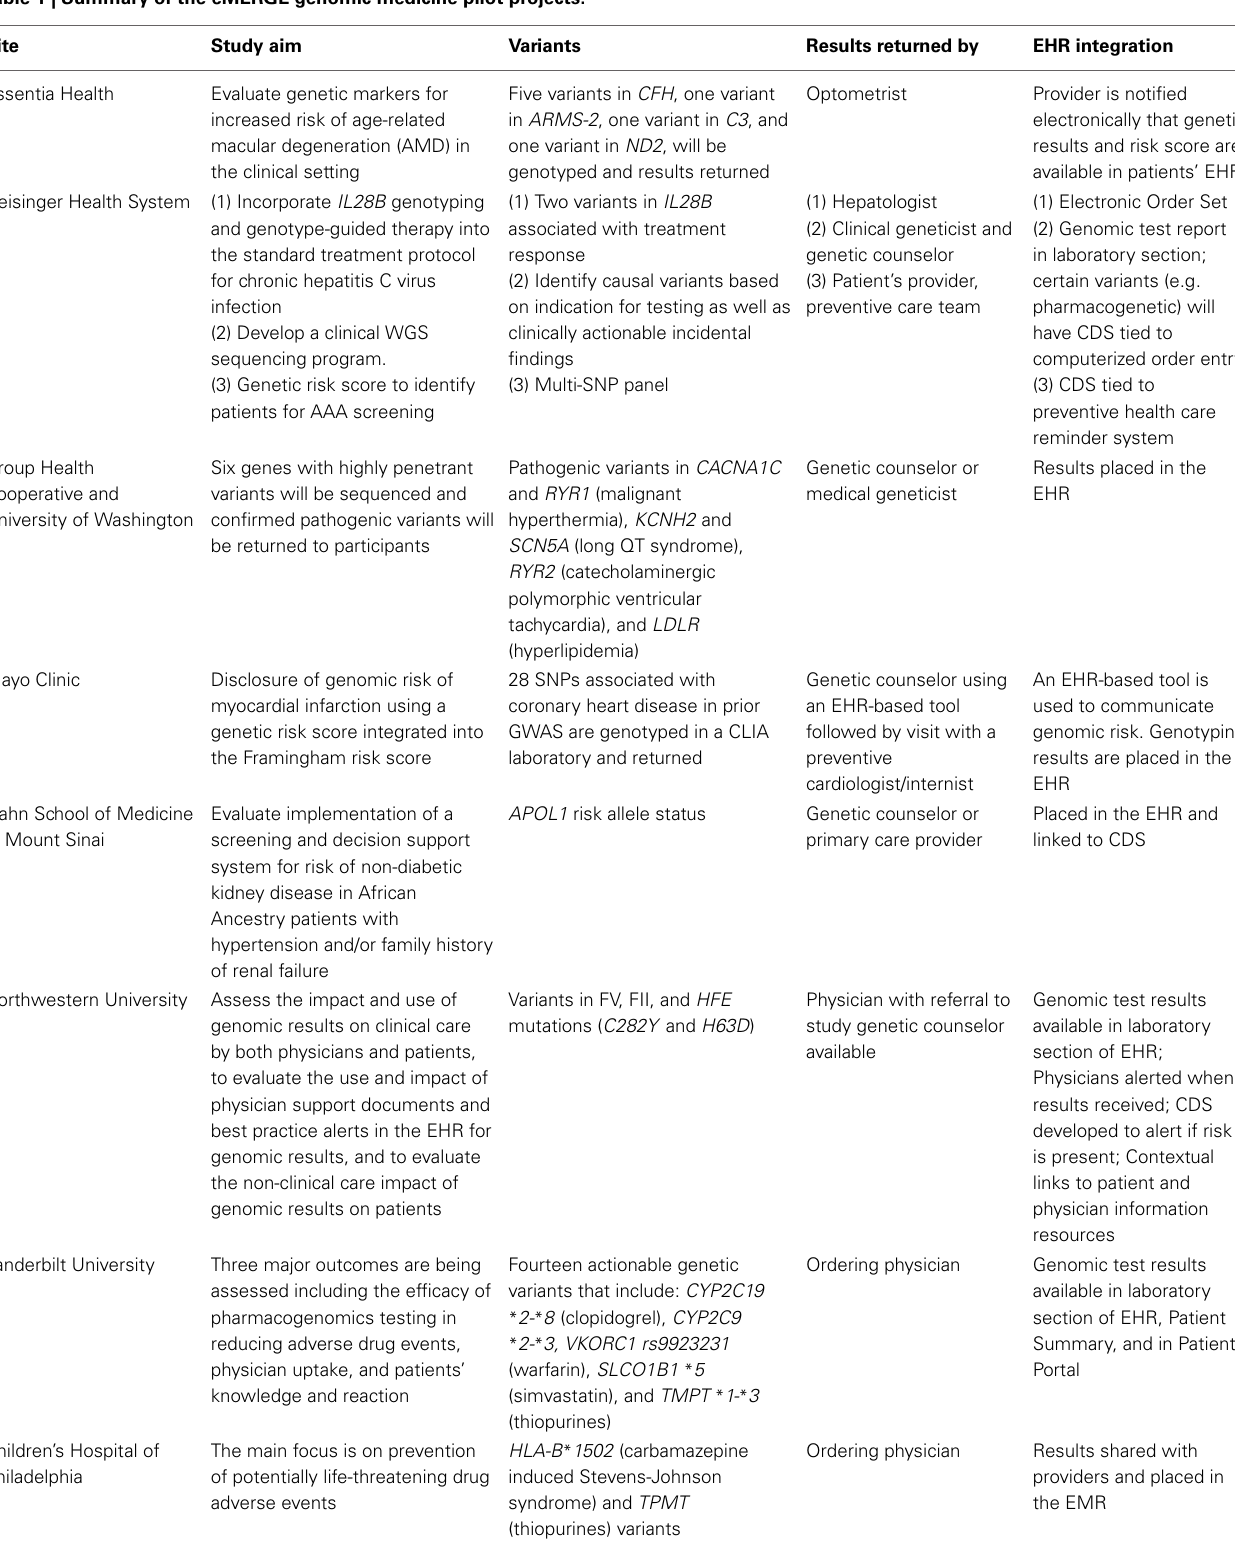
Table 1 | Summary of the eMERGE genomic medicine pilot